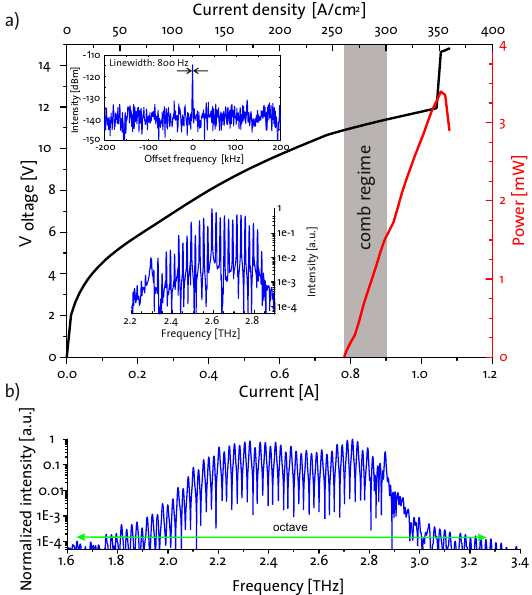
Figure 12: THz QCL comb. a LIV curves of a 2mm x 150 µ m long laser measured at 25 Kelvin in CW operation. The shaded area indicates the current range where the laser operates as a comb. The up- per inset displays the intermode beatnote, showing a linewidth of 800Hz at a driving current of 0.9A. The lower inset shows the corresponding optical spectrum with a bandwidth of 507GHz. b